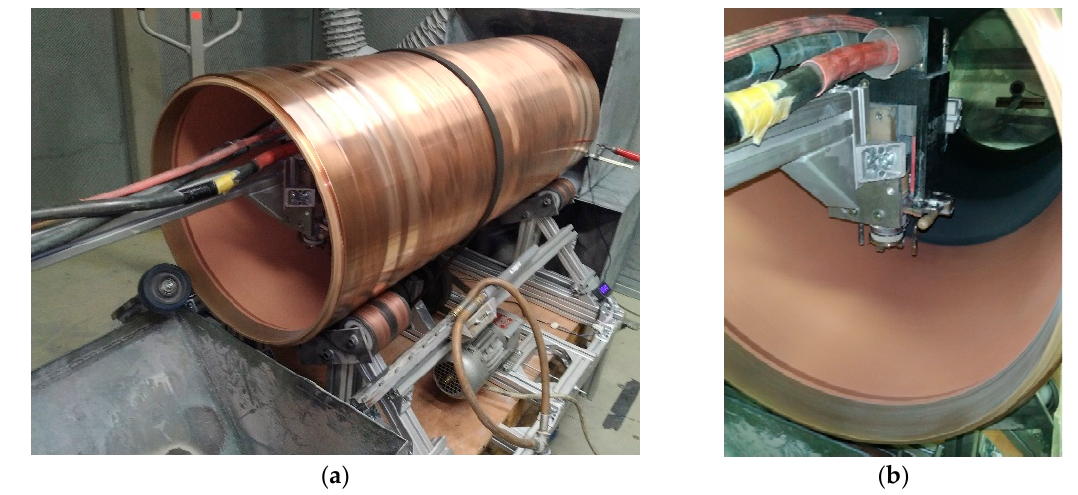
Figure 5. Tube prior to coating operation mounted on a rotational support specially constructed for this purpose. A belt drive was designed to set the tube into rotation during coating ( a ). The plasma torch is mounted on a robot-guided cantilever for internal operation. Plasma torch mount shown in more detail in ( b ).